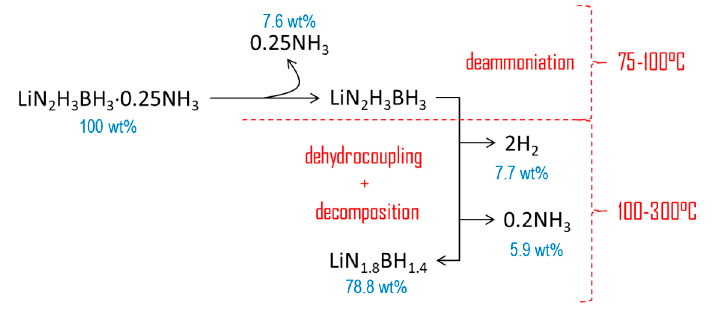
Figure 6. TGA results-based proposition of a decomposition mechanism of LiN 2 H 3 BH 3 ·0.25NH 3 .